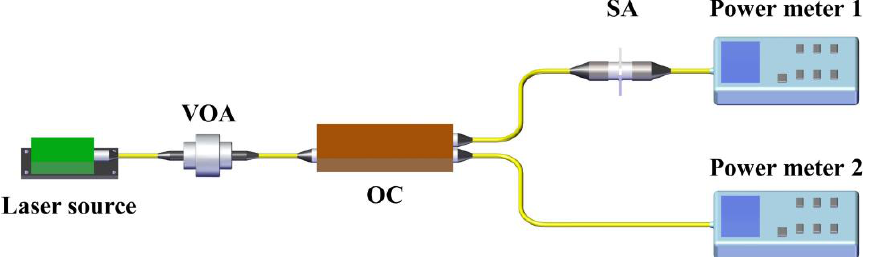
Figure 3. Setup of nonlinear transmission measurement. VOA: variable optical attenuator; OC: output coupler; SA: saturable absorber.